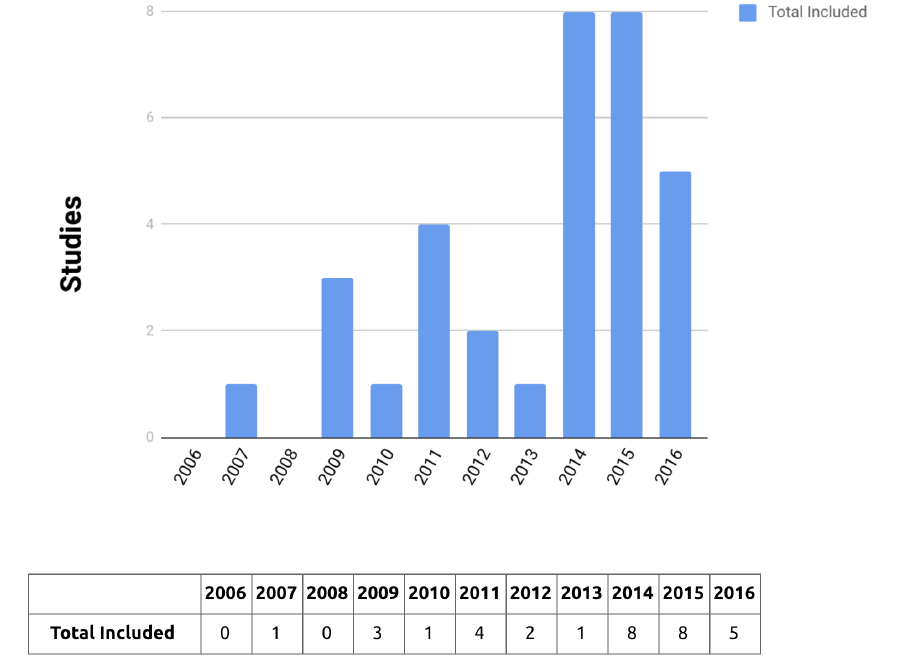
Figure 4. Timeline distribution of